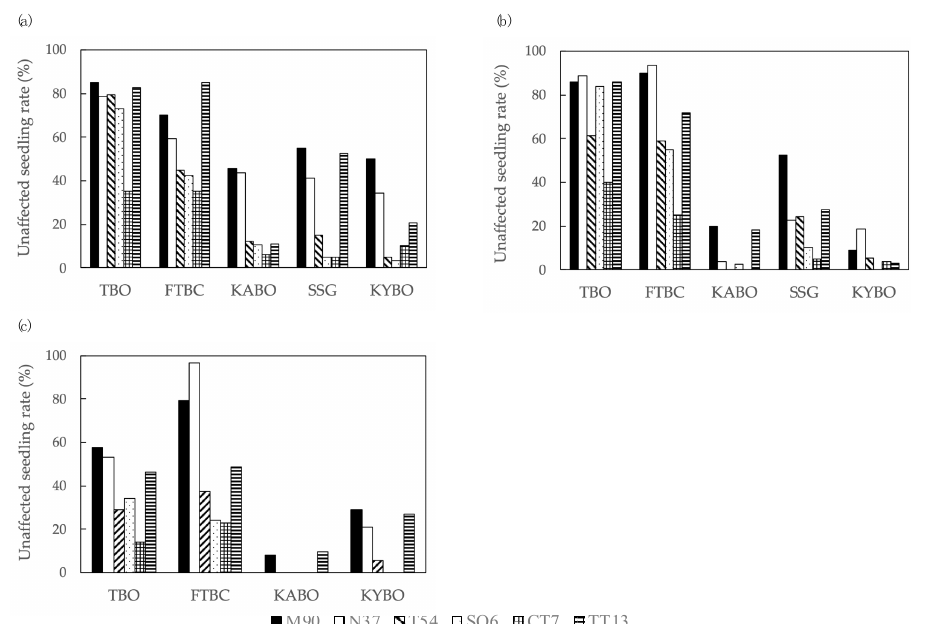
Figure 3. Unaffected seedling rate of P . thunbergii families before inoculation with PWNs in: ( a ) 2015, ( b ) 2016, ( c ) 2017. Test site abbreviations: Tohoku Regional Breeding Office (TBO), Forest Tree Breeding Center (FTBC), Kansai Regional Breeding Office (KABO), Shikoku Breeding Stock Garden (SSG), and Kyushu Regional Breeding Office (KYBO). Family name abbreviations: Misaki 90 (M90), Namikata 37 (N37), Tanabe 54 (T54), Shizuoka (Oosuka) 6 (SO6), Chiba (Tomiura) 7 (CT7), and Tottori (Tottori) 13 (TT13).